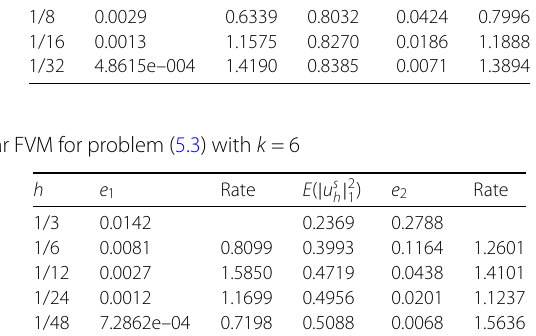
Table 15 The linear FVM for problem (5.3) with k = 12